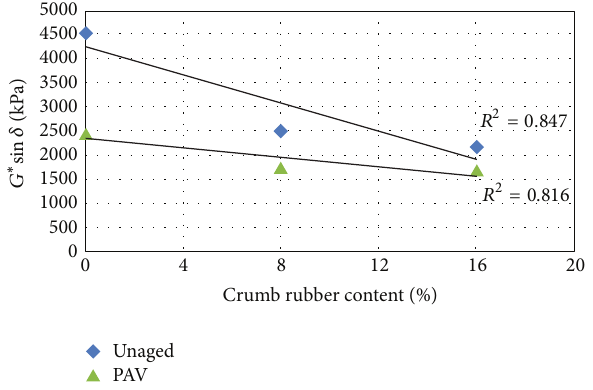
Figure 9: 𝐺 ∗ sin 𝛿 results versus crumb rubber